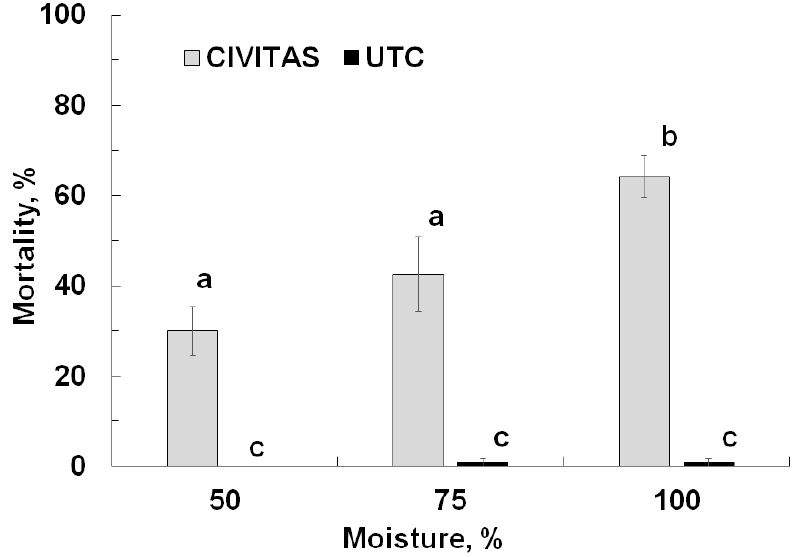
Figure 5. Mortality of Listronotus maculicollis (not corrected) adults caused by Civitas (54.1 L/ha applied in 1630 L/ha carrier volume) at different soil moisture levels. Means marked with the same letter do not differ